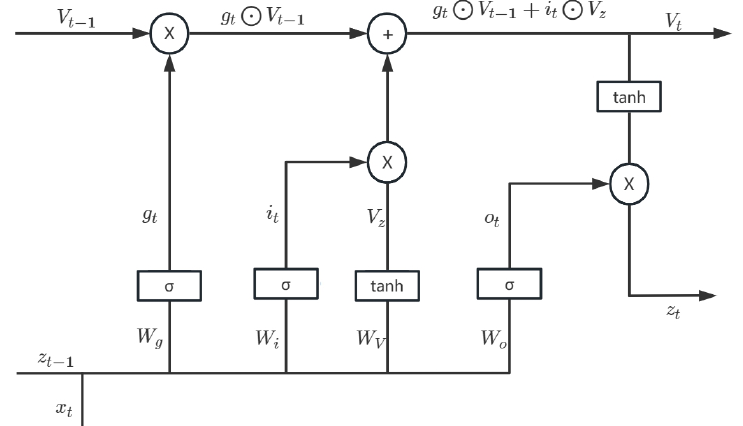
Figure 8. LSTM unit